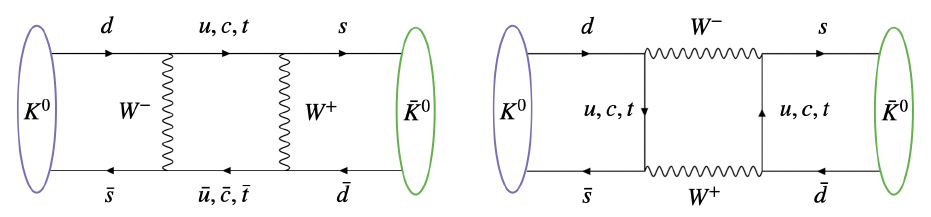
Figure 1. Because weak interactions do not conserve strangeness, we can have these types of box diagrams representing the transformation of a neutral kaon into its